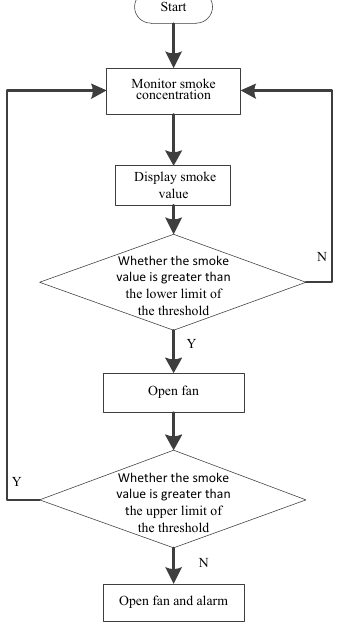
Fig. 7. The flowchart of the smoke collection module.